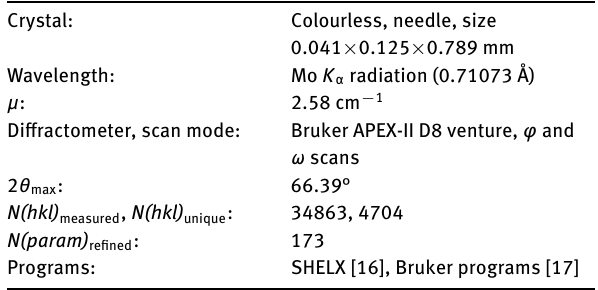
Table 2: Fractional atomic coordinates and isotropic or